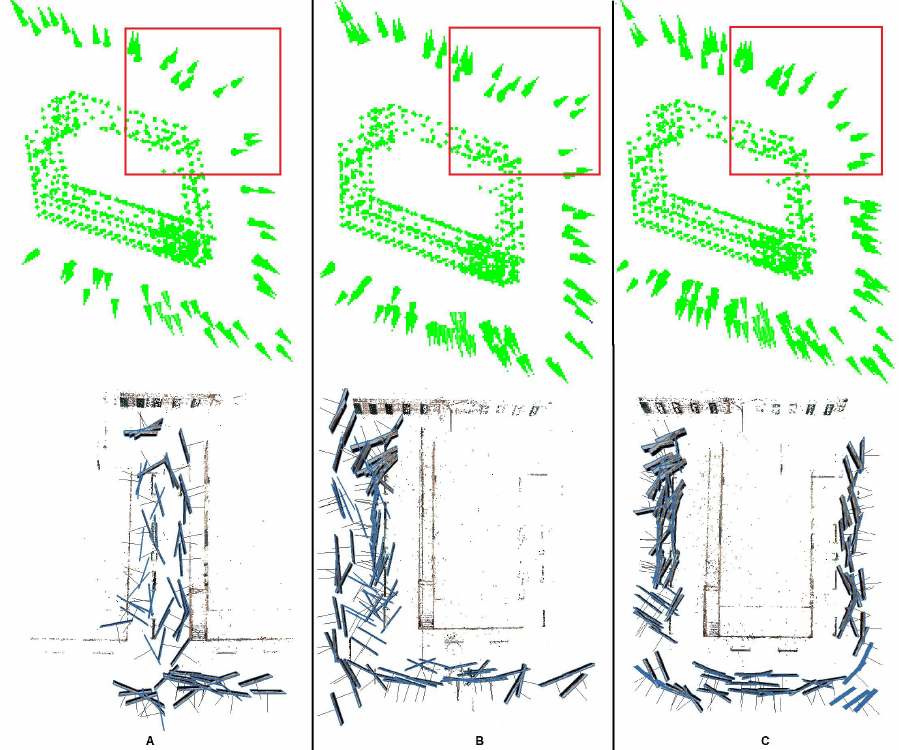
Figure 11. The selected viewpoints of the centre pointing imaging network for different incidence angles (( A ): 20, ( B ): 40 and ( C ): 60 degrees) in viewpoint selection step ( top ) and SfM step ( bottom